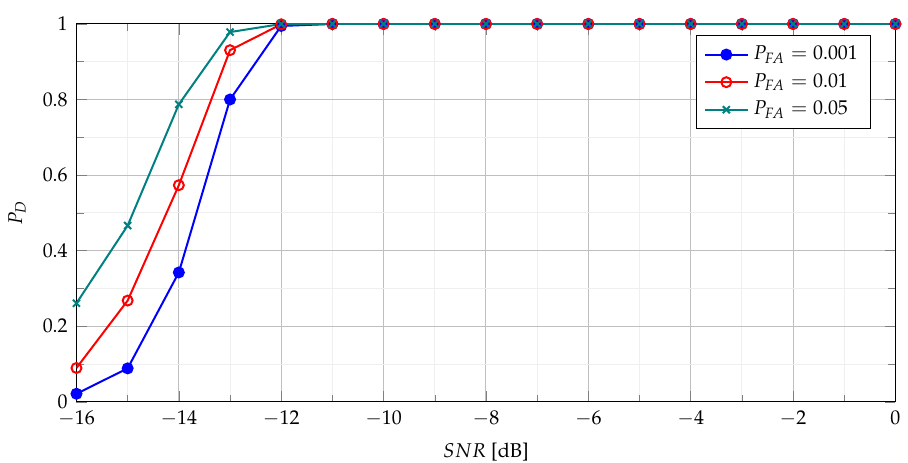
0,1, . . . ,30 . Figure 8. Probability of detection with use of the TPCPF statistics employing slices n = 0,1, . . . ,30 . 0,1, . . . ,30 . { } { } { }